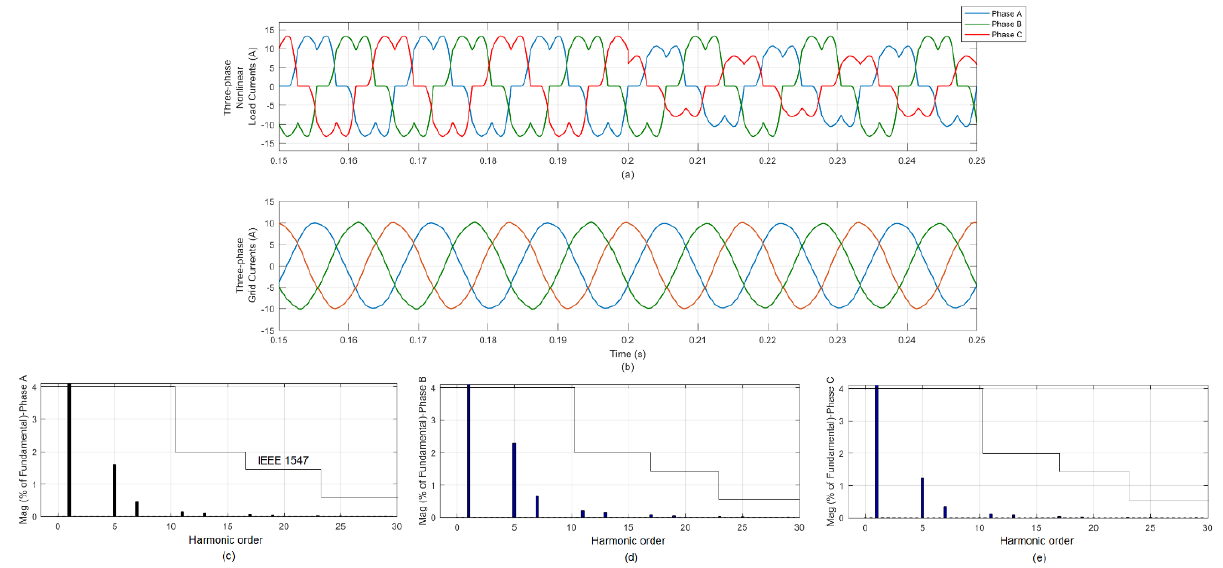
Figure 6. ( a ) Three-phase inductors current, ( b ) three-phase grid current, ( c , d ) of the three-phases of the grid currents (Phase A in ( c ), Phase B in ( d ), and Phase C in ( e )) and the limits of IEEE 1547 Standard during unbalanced nonlinear load.